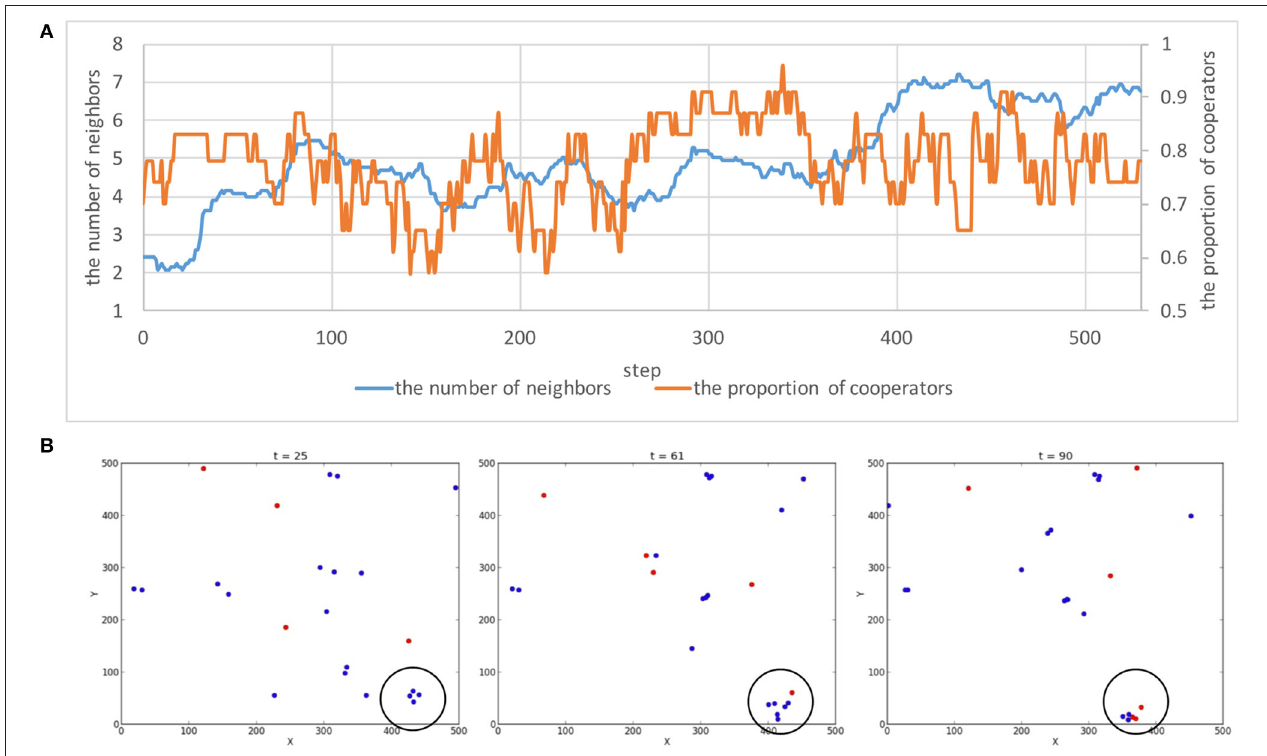
FIGURE 2 | (A) The temporal dynamics of the proportion of cooperators and the average number of neighbors in E1-S3. (B) An example transition of the social dynamics in E1-S3 that were typically observed in the all experimental trials. Blue, cooperators; red, defectors. (Left) A spontaneous formation of cooperative cluster, (Center) a growing cluster, (Right) an escape from defectors. We can also see some other clusters of cooperators in the field.